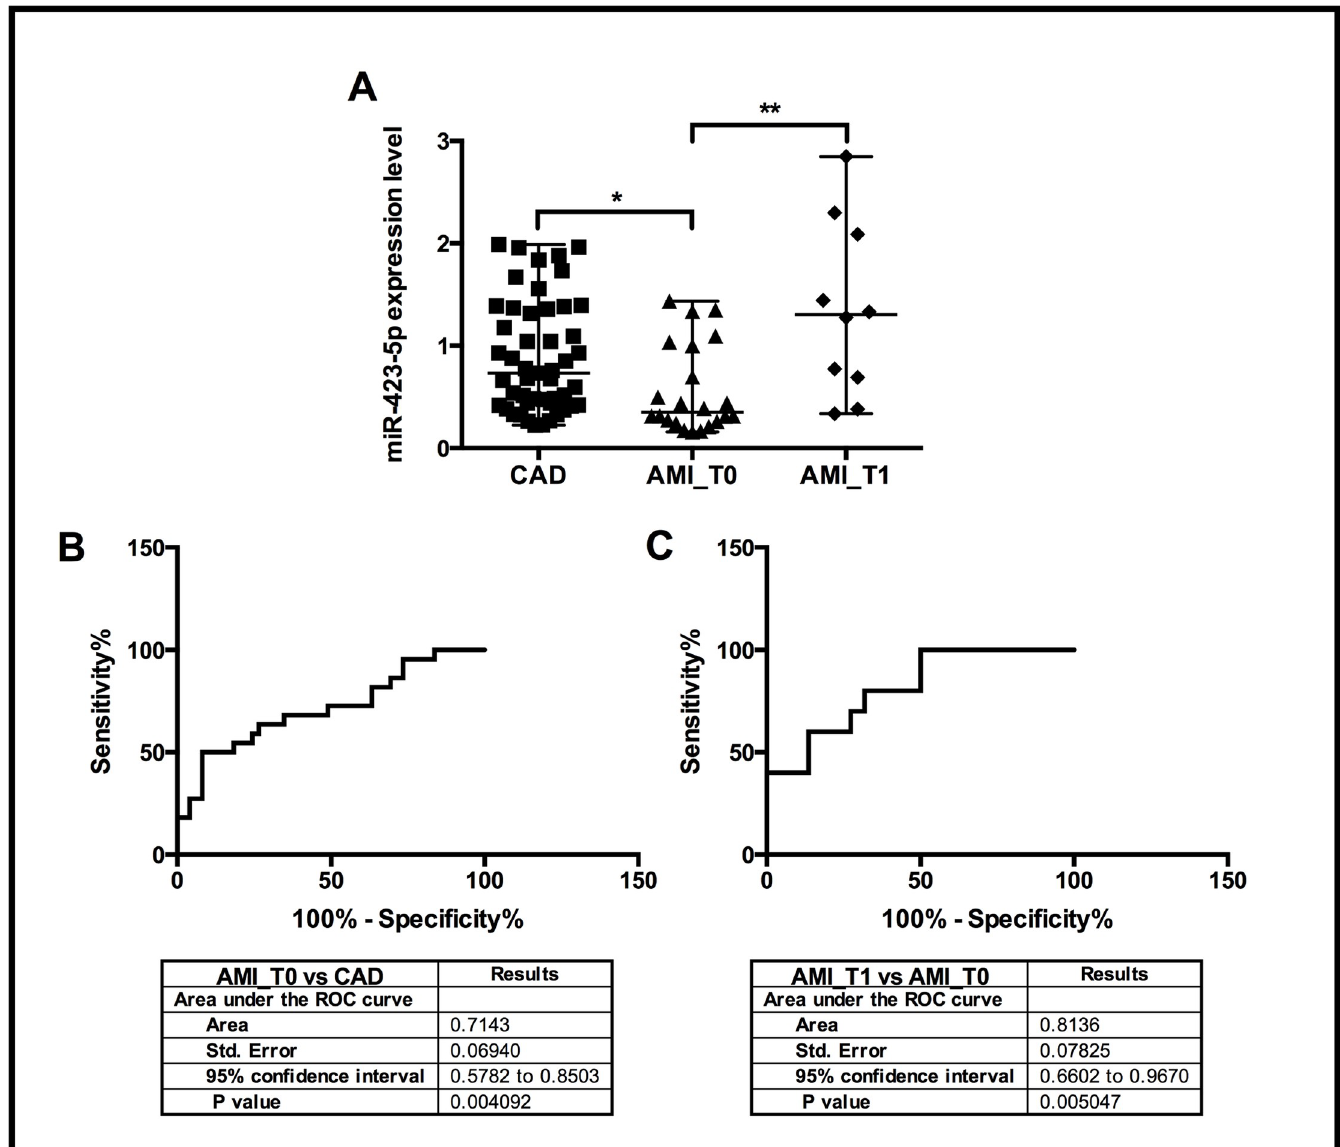
Fig 4. Circulating miR-423-5p expression (n = 3). (A) Circulating miR-423-5p expression in CAD, AMI_T0 and AMI_T1 groups. Kruskal-Wallis statistic 12.20, p = 0.0022; Dunn’s multiple comparisons test � p � 0.05, �� p � 0.005. Discriminatory power of plasma miR-423-5p. (B) Receiver operator characteristic (ROC) curves for AMI_T0 vs CAD (set as control group). (C) Receiver operator characteristic (ROC) curves for AMI_T1 vs AMI_T0 (set as control group).